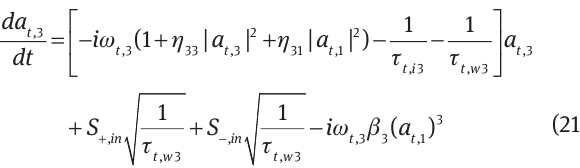
, τ , τ , and τ various with (D) Fermi energy E and (E) refractive index n w 1 w 2 i 1 i 2 f 1